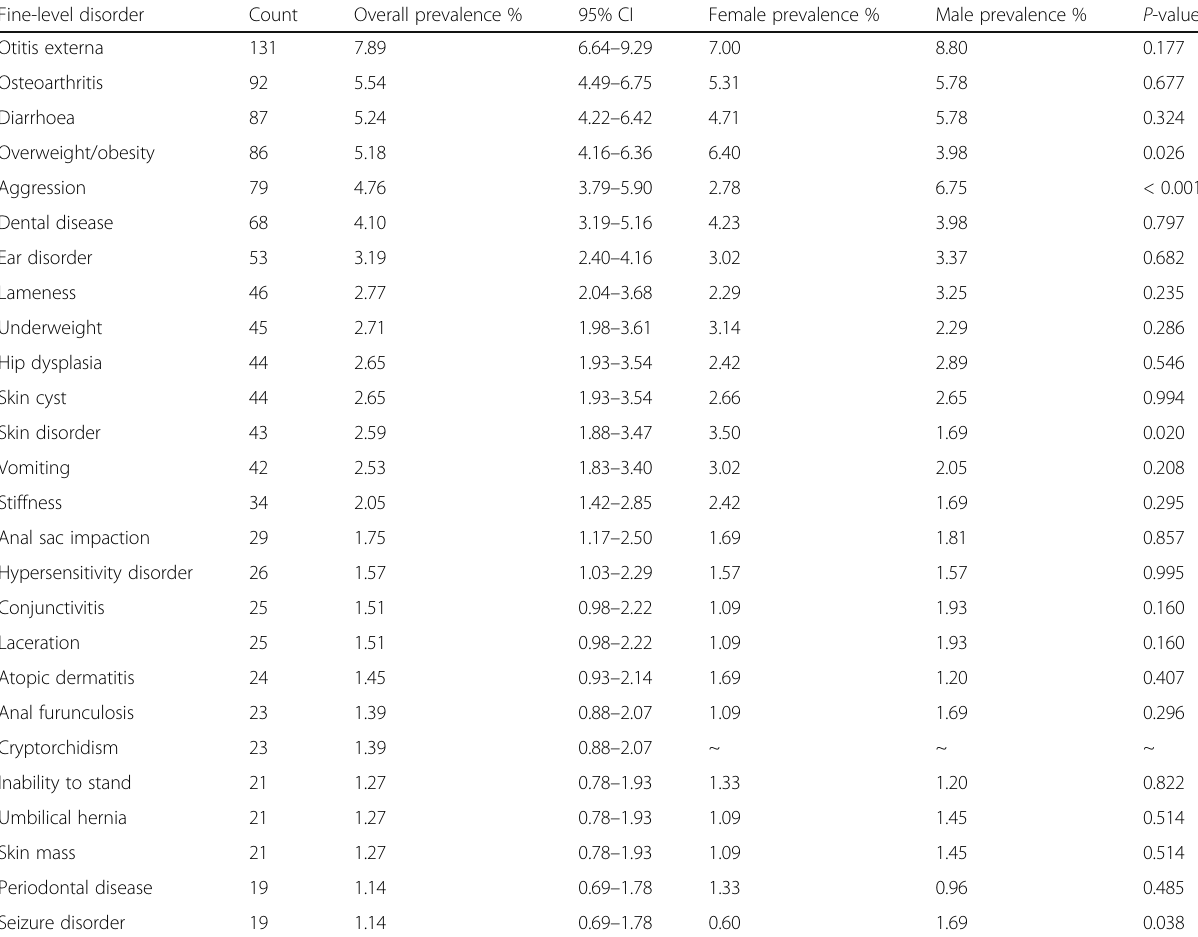
Table 3 Prevalence of the most common disorders at their fine-level (greatest) diagnostic precision recorded in German Shepherds Dogs ( n = 1660) attending UK primary-care veterinary practices participating in the VetCompass TM Programme from January